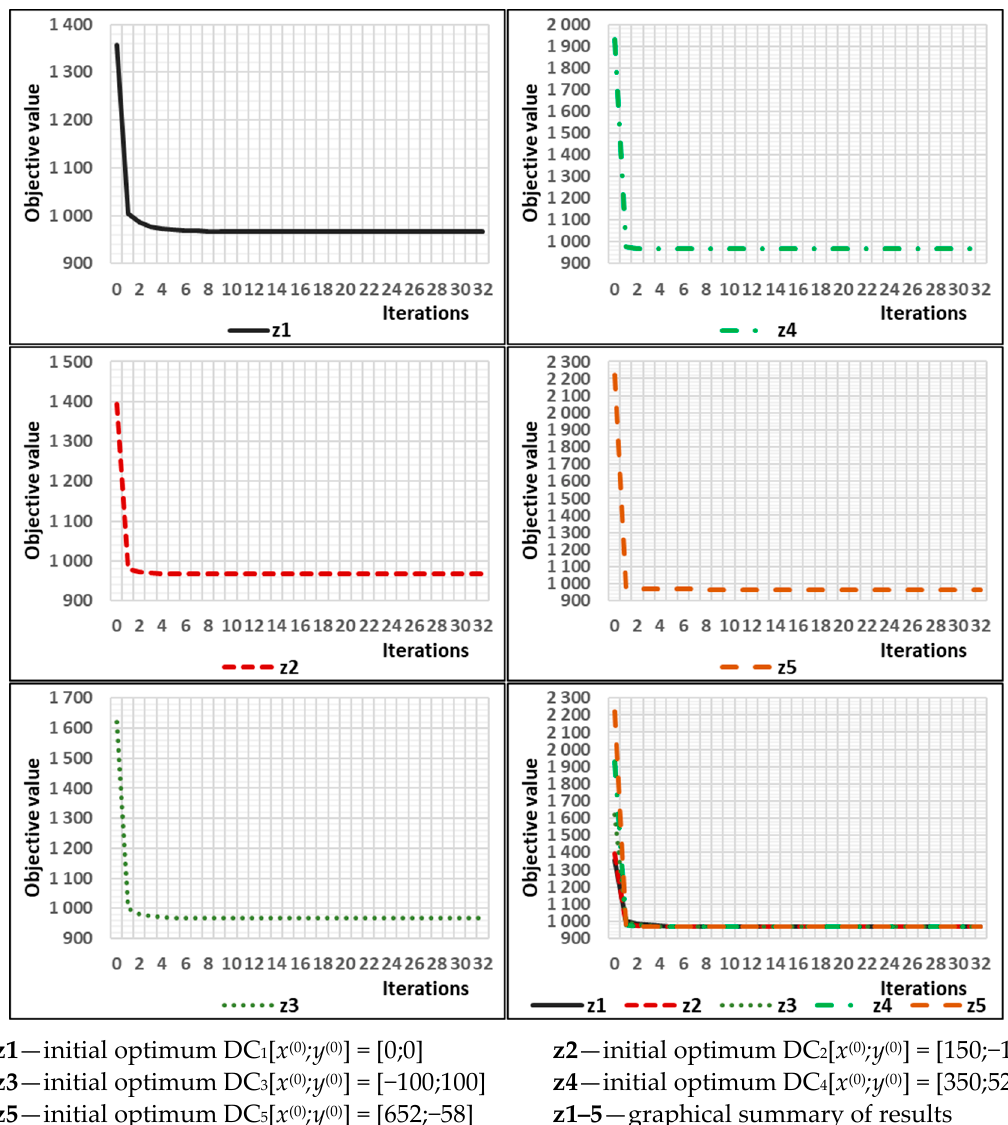
Figure 13. Graphical display of results of the objective function values calculating iterations from five different starting points.